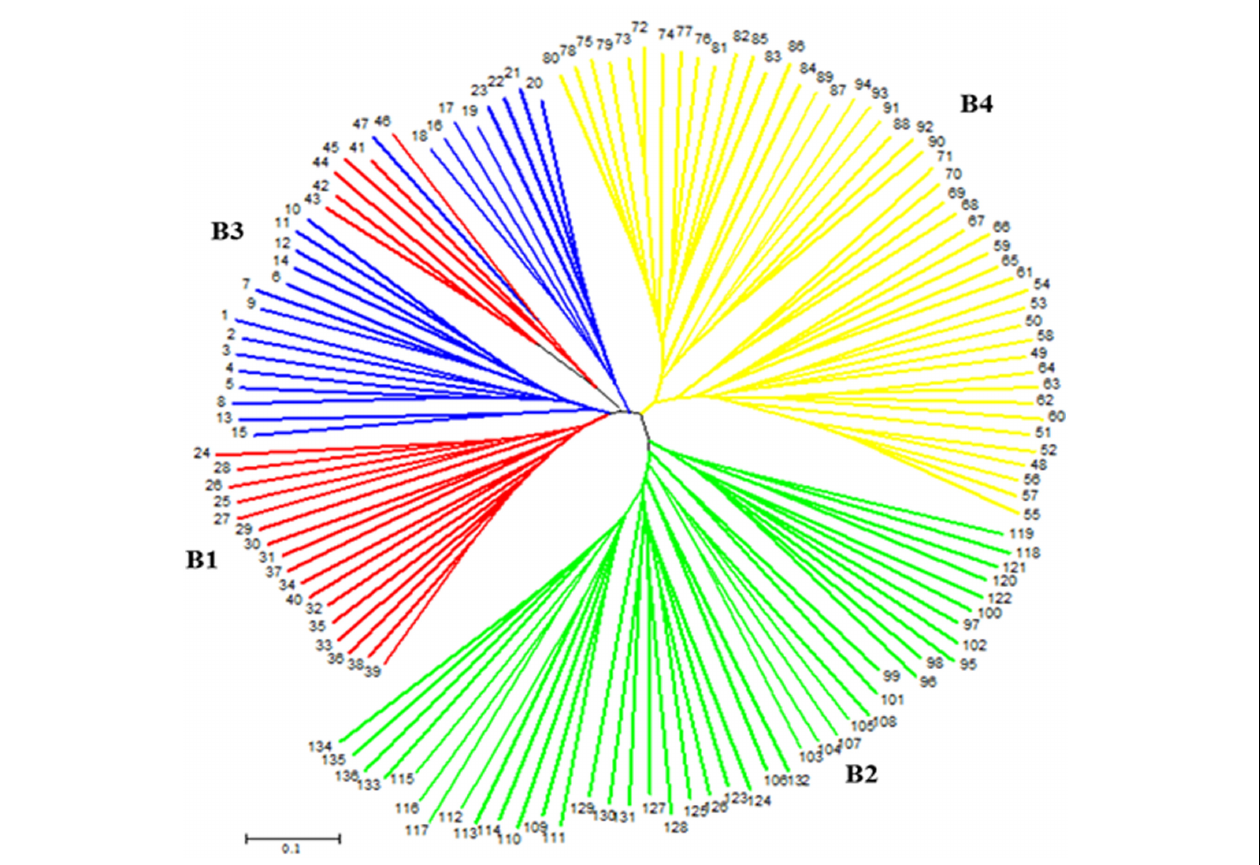
FIGURE 2 | An unrooted neighbor-joining tree (NJ) showing genetic relationships of 136 sorghum accessions based on 50 simple sequence repeat (SSR) markers. The four subpopulations are labeled B1–B4 and numbers at tip of the branches indicate accession numbers. The color codes are from the structure output presented in Figure 1